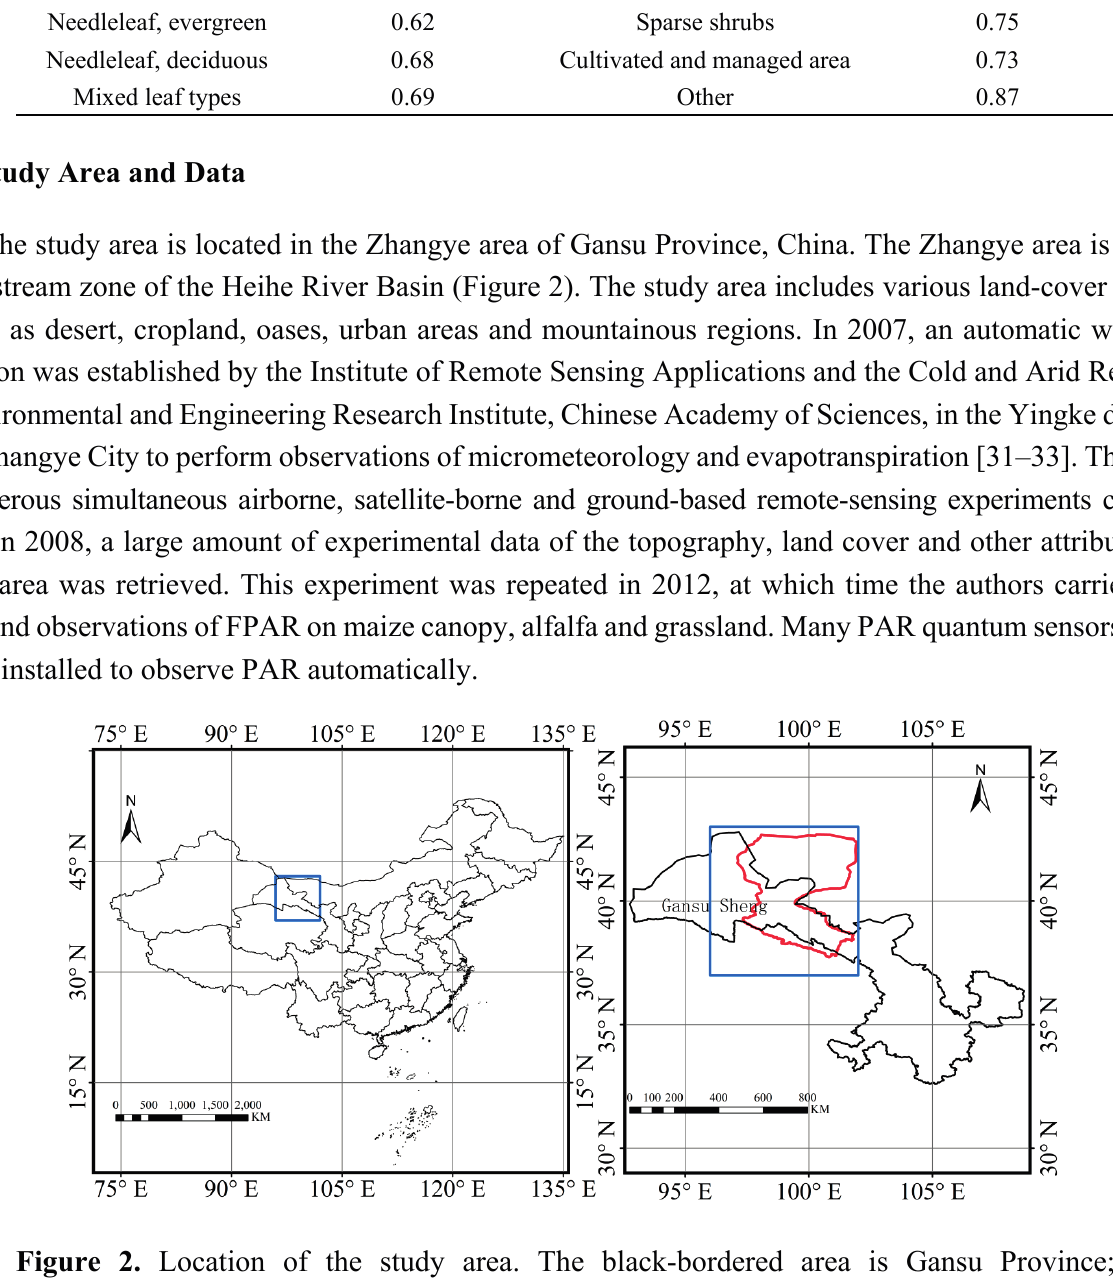
Figure 2. Location of the study area. The black-bordered area is Gansu Province; the red-bordered area is the Heihe River Basin; and the blue-bordered area is the region covered by the remote sensing images used for FPAR inversion in this